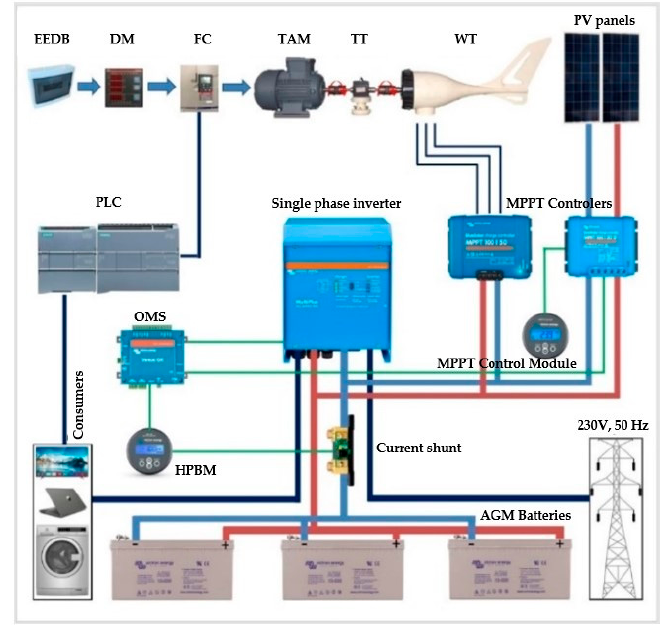
Figure 2. HRES wiring diagram.